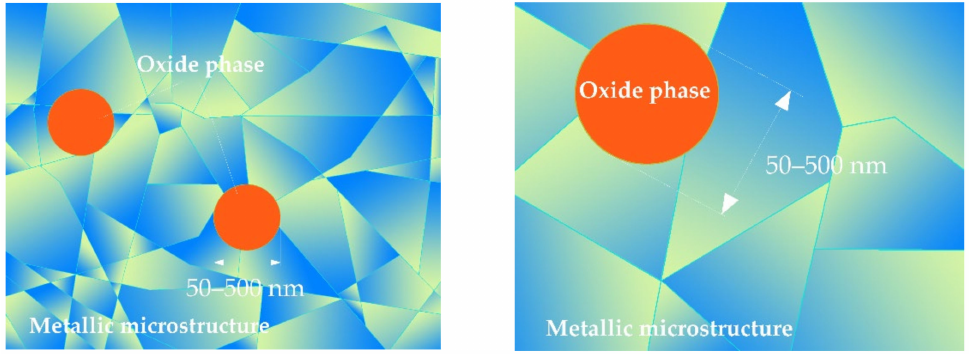
Figure 2. Oxide nanoparticles correspond to a small extent to steel obtained by